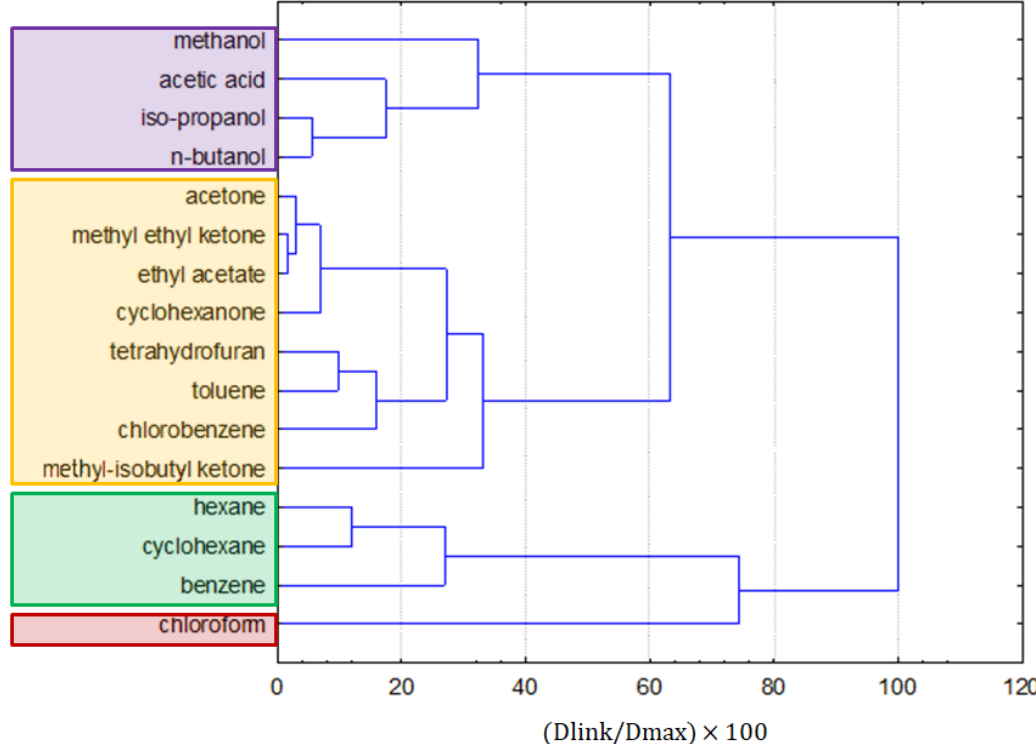
Figure 9. The hierarchical dendrogram for the linkage of 16 solvents.